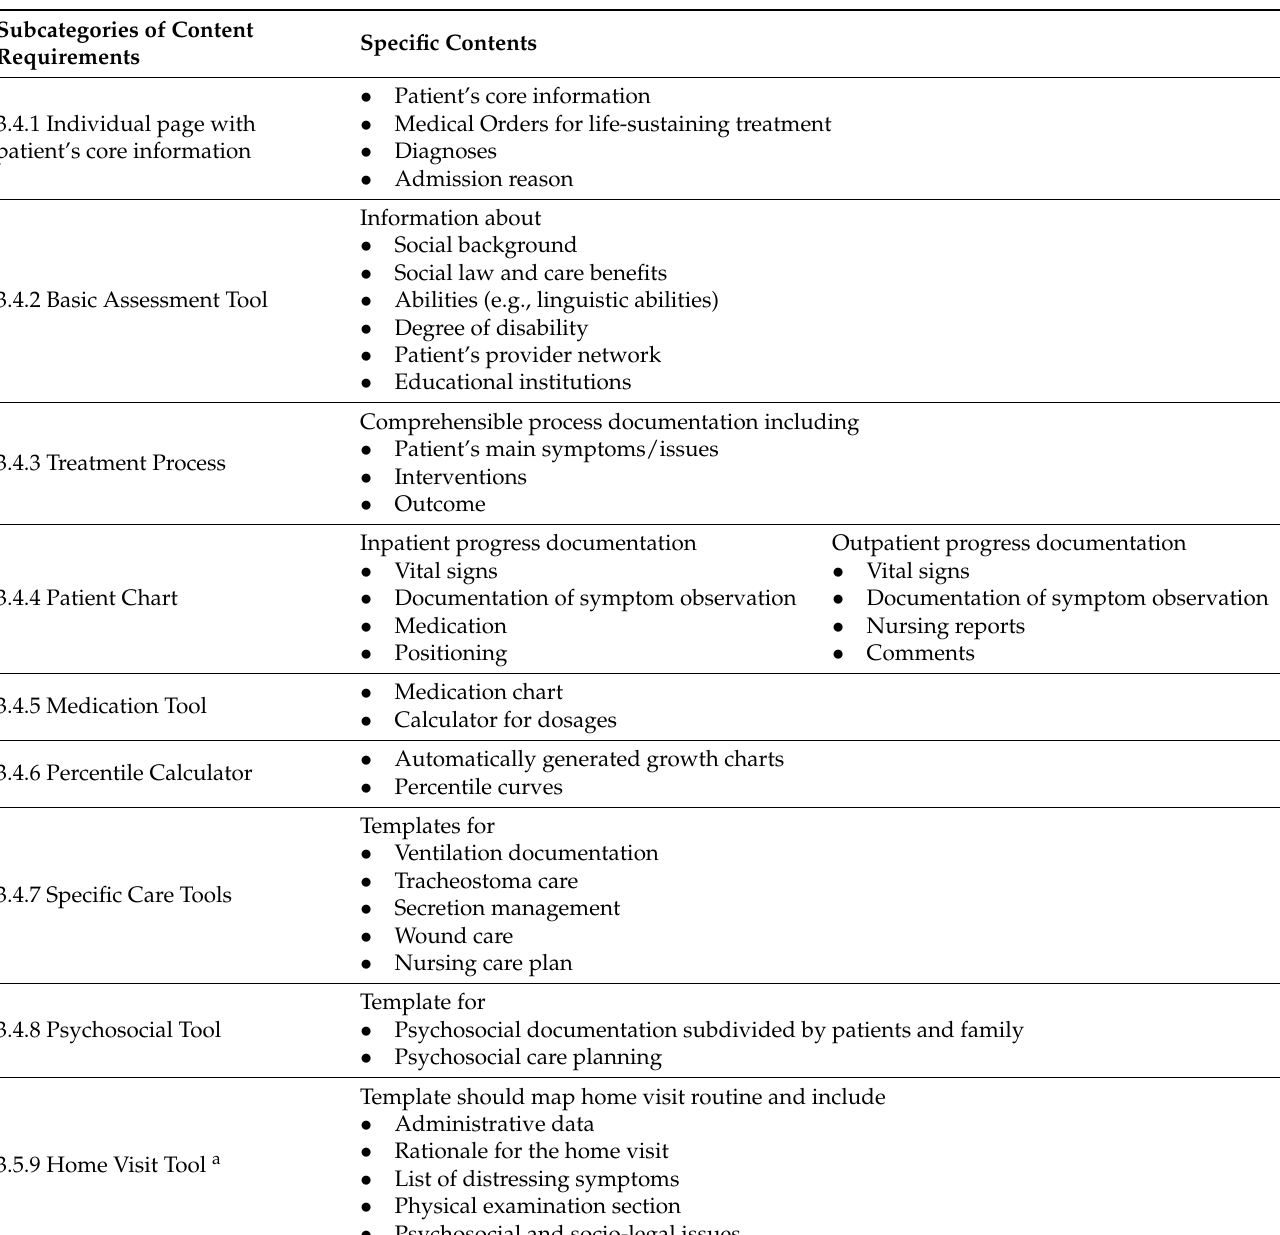
Table 3. Content requirements for an